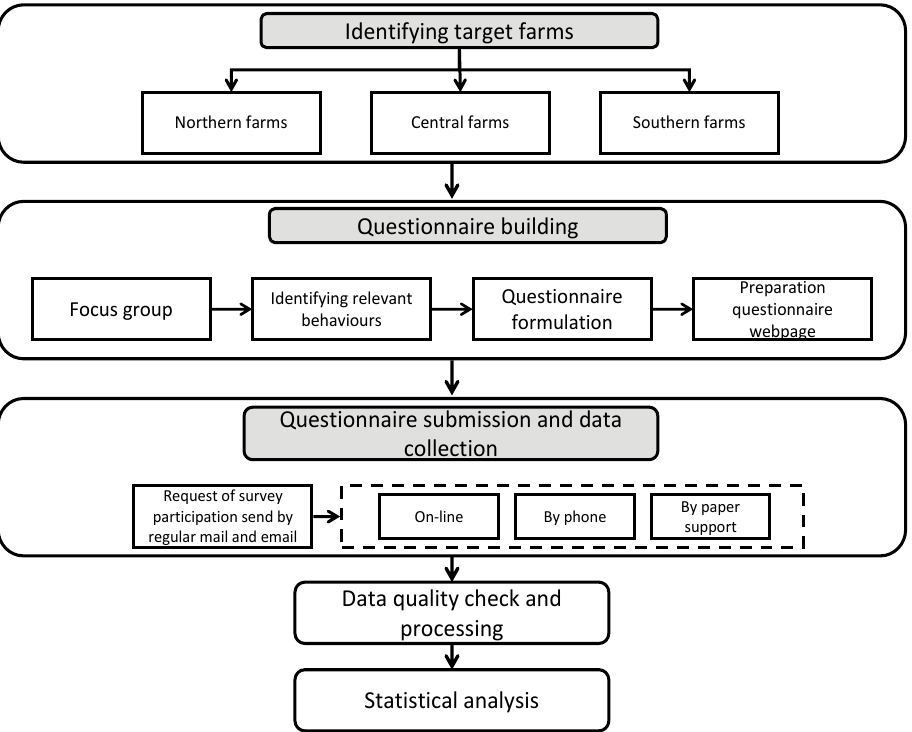
Figure 1. Analysis